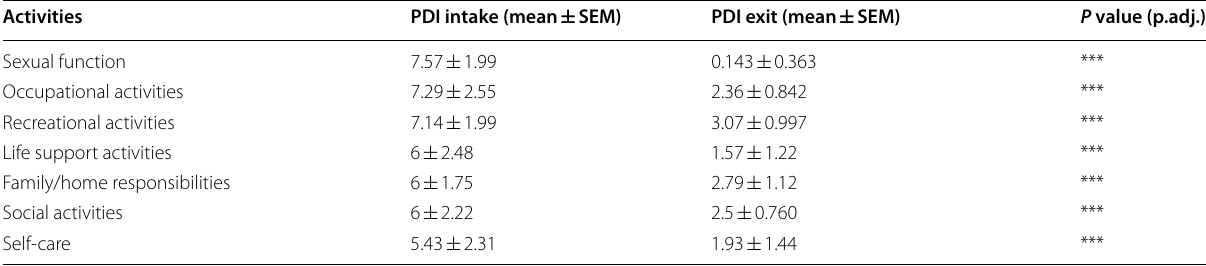
Table 3 Mean differences between intake and exit scores on the Pain Disability Index (PDI). Data are subdivided by the type of activity. The activities are ranked according to self-reported disability at intake, from highest to lowest level of self-reported disability. These data are presented from the 14 participants who completed the study. Data are presented as the mean value and the standard error of the mean (SEM). Significance was determined using the pairwise t -test. *** p <